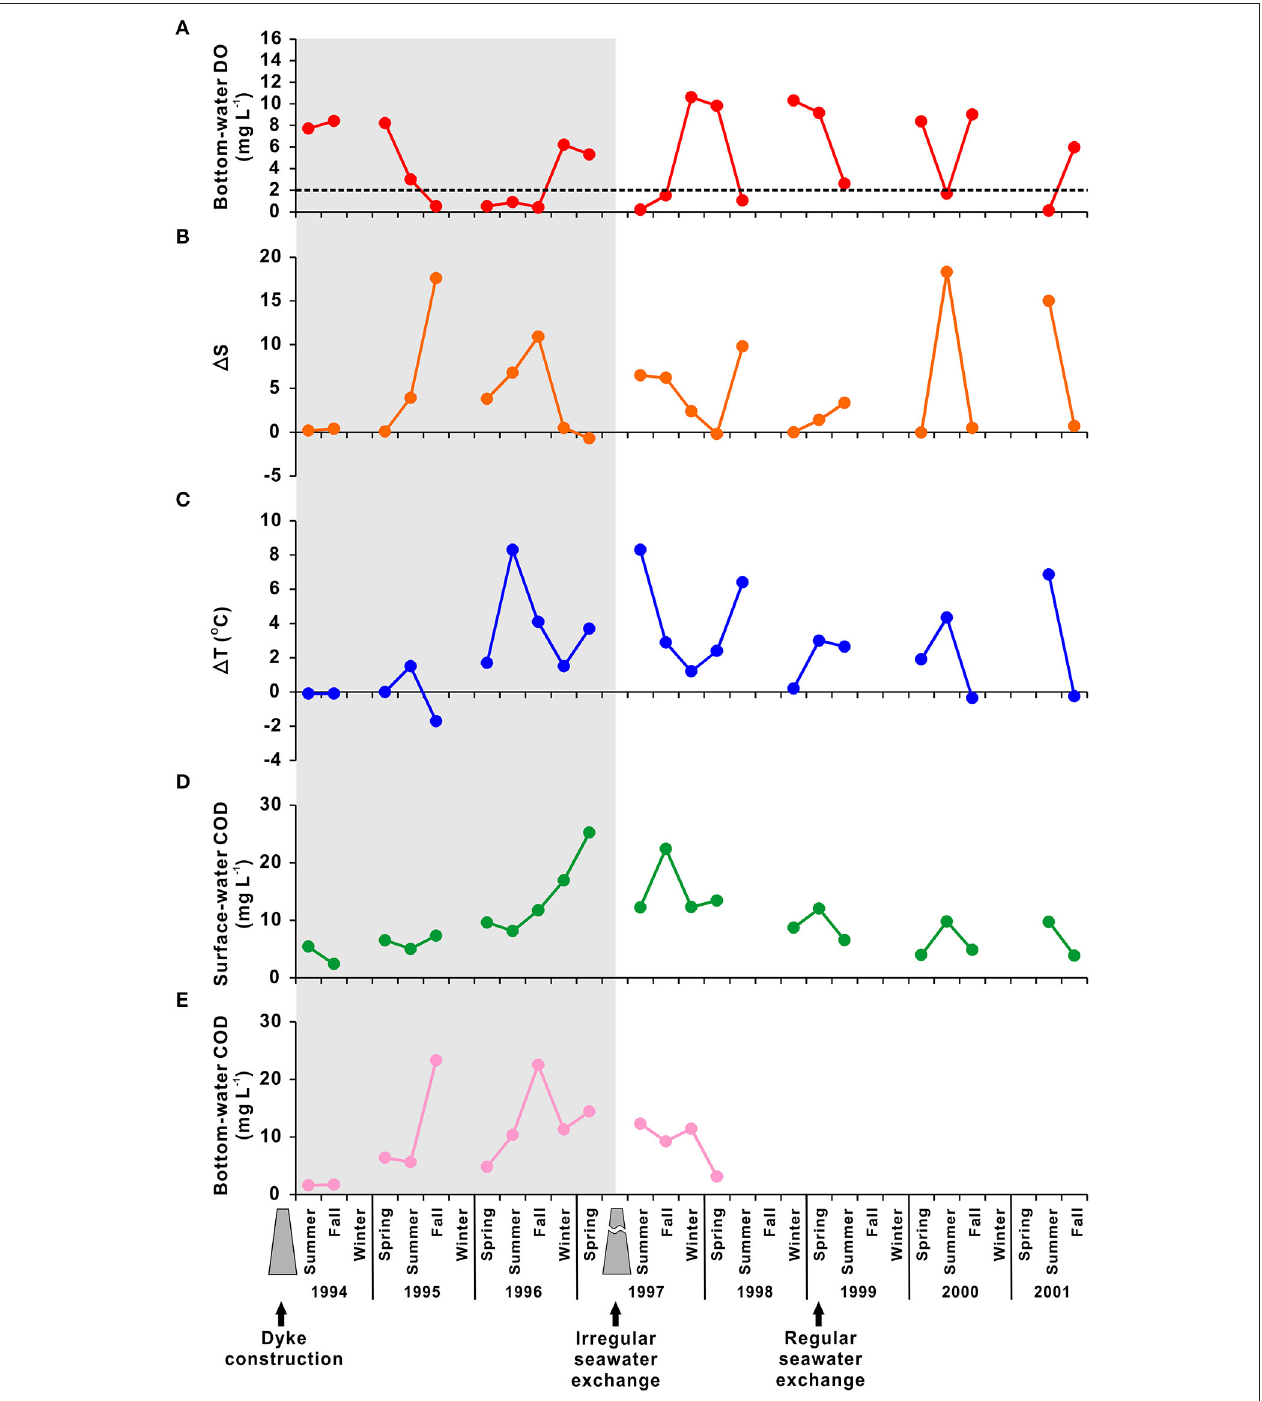
FIGURE 8 | Temporal variation in (A) bottom-water dissolved oxygen (DO; mg L − 1 ), (B) 1 S (i.e., the difference between surface and bottom salinity), (C) 1 T (i.e., the difference between surface and bottom temperatures; ◦ C), (D) surface chemical oxygen demand (COD; mg L − 1 ), and (E) bottom COD observed during 1994–2001 in Shihwa Bay. The shaded area represents the period of desalination after construction of a dyke (i.e., 1994–1997). The dotted line in (A) represents hypoxia (DO < 2mg L − 1 ). The data sources are Choi (2001) and Park et al. (2003).